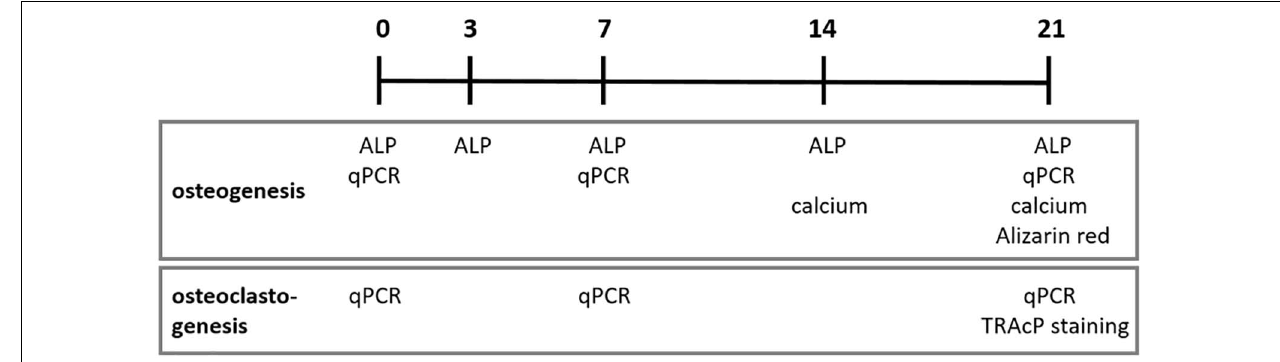
FIGURE 1 | Osteogenesis and osteoclastogenesis assays at different time points in days. ALP, alkaline phosphatase activity; qPCR, quantitative polymerase chain reaction; TRAcP, Tartrate-resistant acid phosphatase.